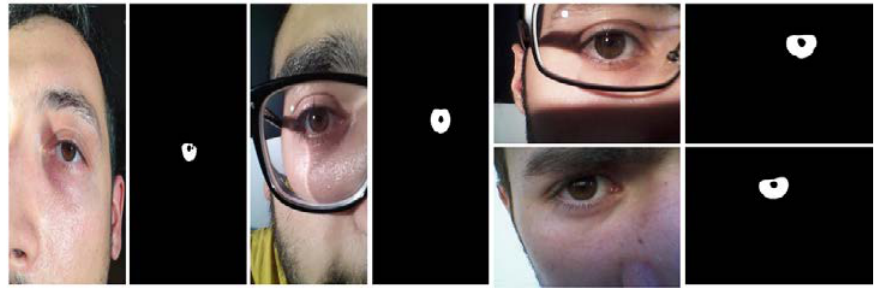
Figure 10. Mobile iris challenge evaluation (MICHE-I) sample images with corresponding ground Figure truths.